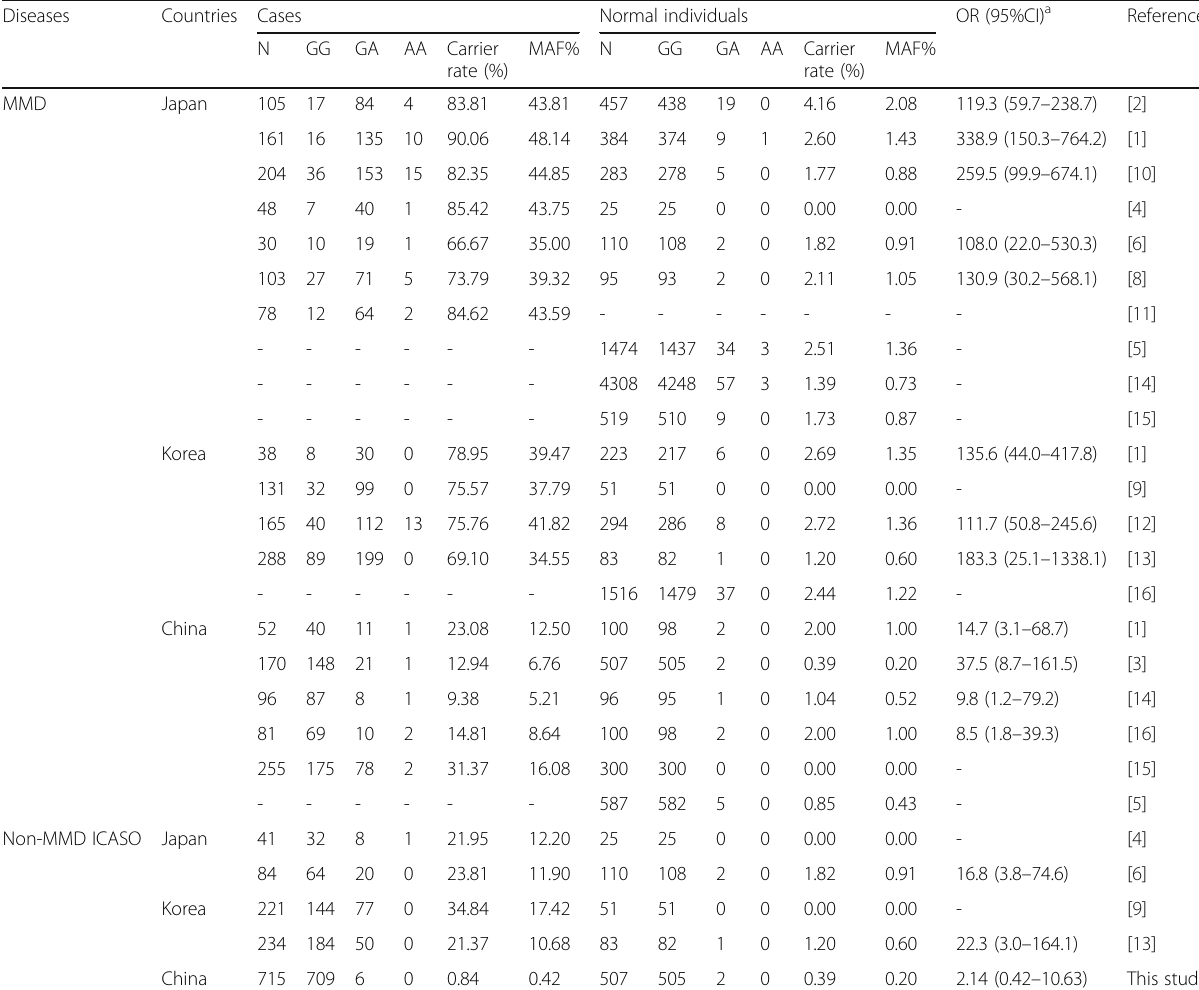
Table 3 Comparision of RNF213 p.R4810K distribution in MMD, non-MMD ICASO and normal individuals in Japan, Korea and China Diseases Countries